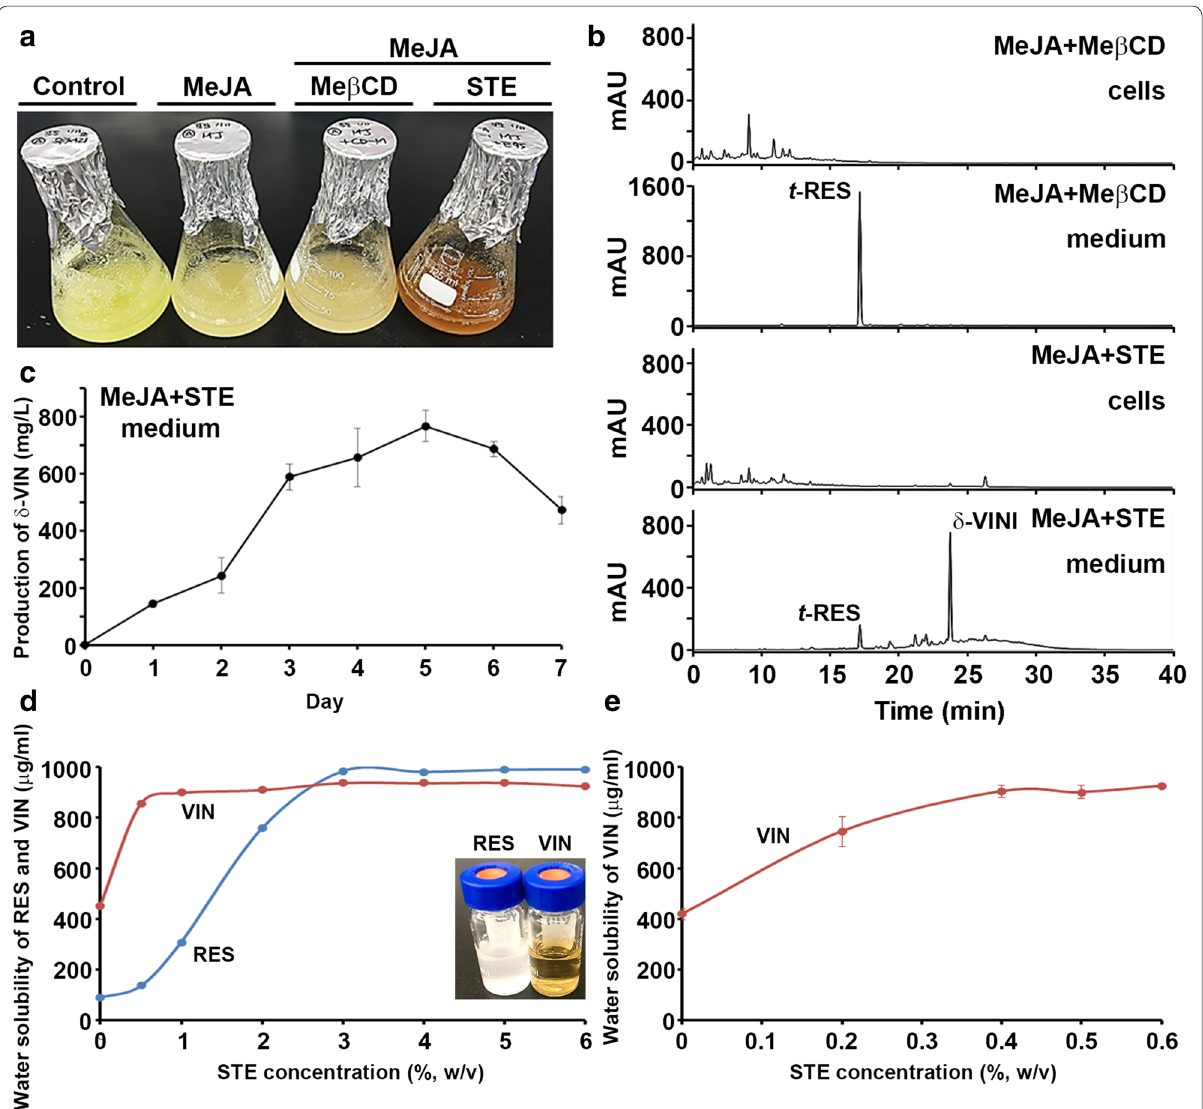
Fig. 4 Extracellular production of trans ‑resveratrol and δ‑viniferin in the grapevine cell culture medium. a , b Extracellular production of trans ‑resveratrol and δ‑viniferin in grapevine cell culture medium after treatment with different solubilizers. Cells were pre‑cultured for 7 days and harvested 5 days after co‑application of 100 µM MeJA and 50 mM MeβCD or 50 mM STE as a solubilizer. c Time‑course of δ‑viniferin production in grapevine cell culture medium after co‑treatment with MeJA and STE. d , e Water solubility enhancement of trans ‑resveratrol and δ‑viniferin in STE solution. The solubility of trans ‑resveratrol (blue) and δ‑viniferin (red) in aqueous solution with increasing STE concentrations (%, w/v) was determined. (Insert) Images of trans ‑resveratrol (RES) and δ‑viniferin (VIN) dispersion with 0.5% STE concentration (w/v). The culture medium of the elicited cells was extracted with ethyl acetate and analyzed by